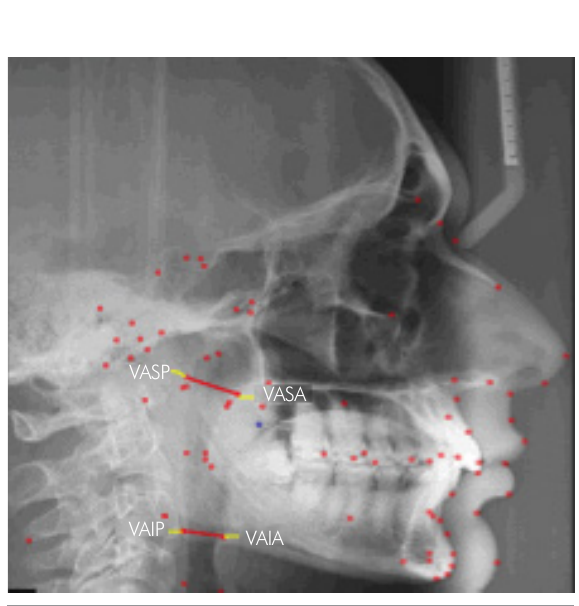
Figure 2. Schematic lateral cephalogram illustrating the upper pharyngeal space (VASP–VASA) and lower airway space